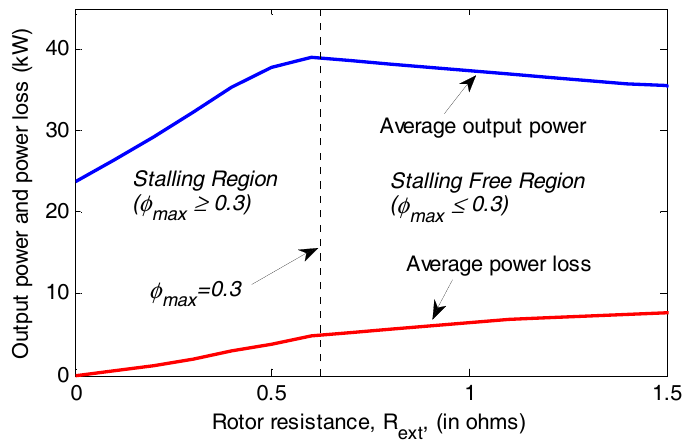
Figure 6. P g and P L versus R ext for dP = | 7000 sin (0.314 t )| Pa .